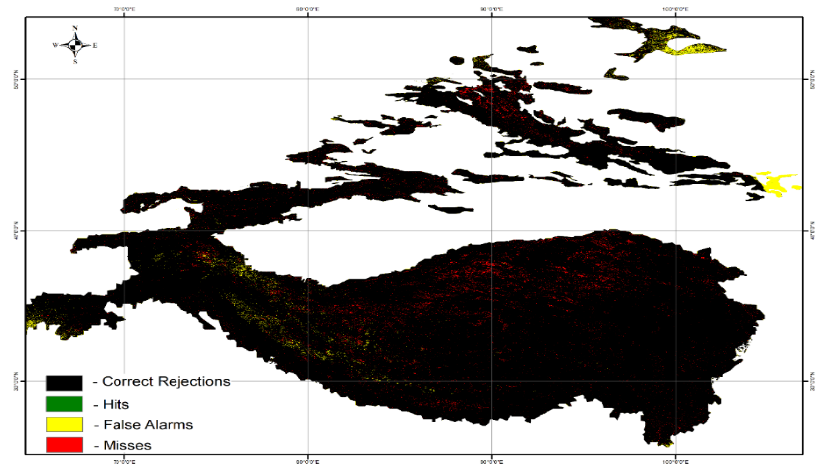
Figure 3. The quantity and allocation disagreement, showcasing the validation of the simulated map with the reference map.